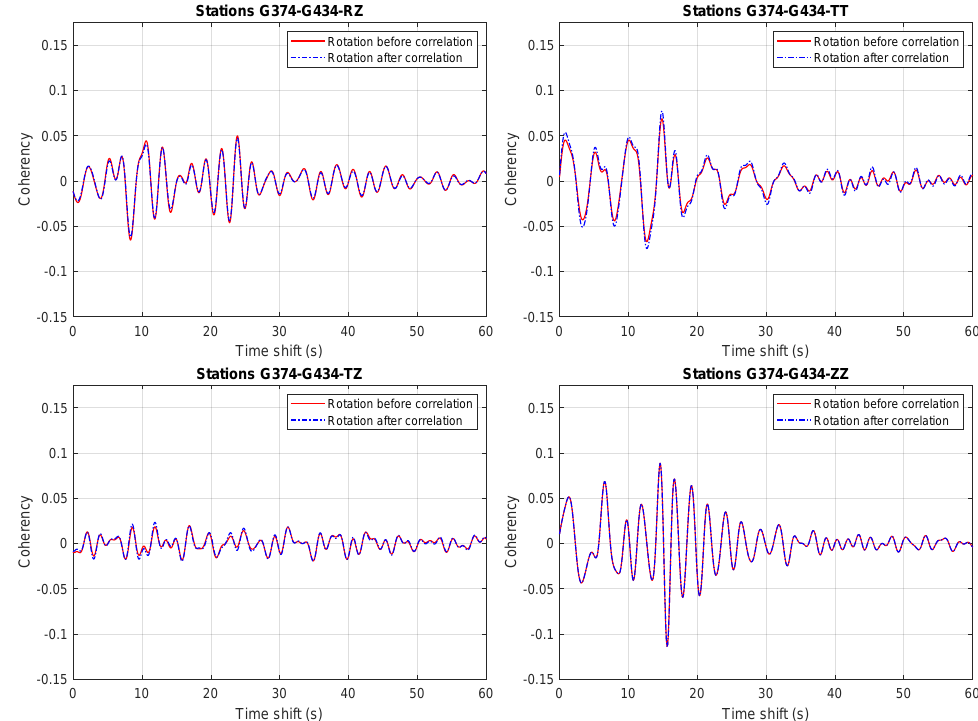
Figure A1. Comparison of applying rotation before or after cross-correlation using spectral normal- ization for different component combinations and for receiver pair